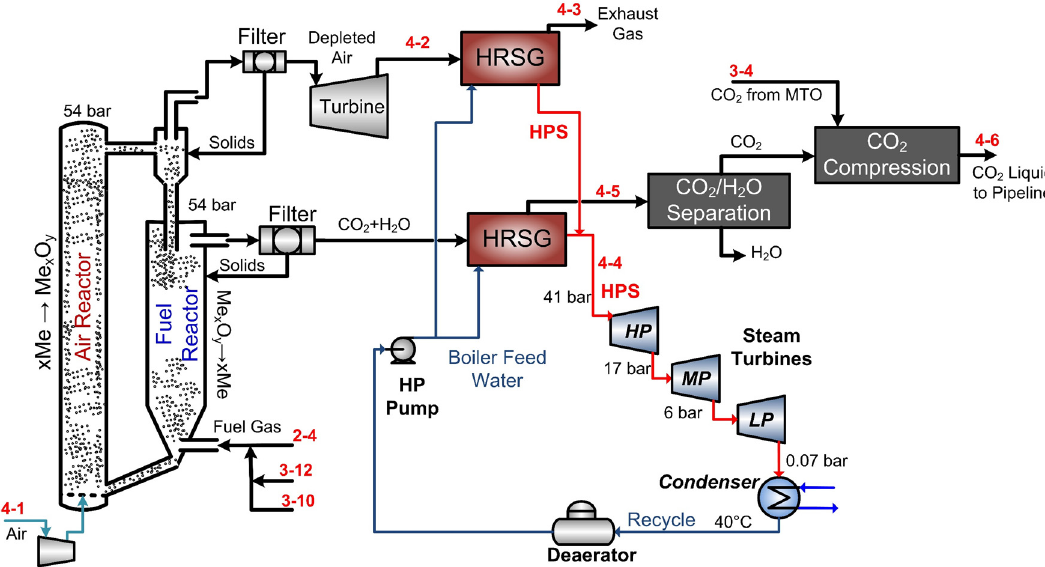
Figure 7. Section 4 Options 3 and 4: Power generation with chemical looping combustion based on sub-pilot plant constructed by Ishida et al.